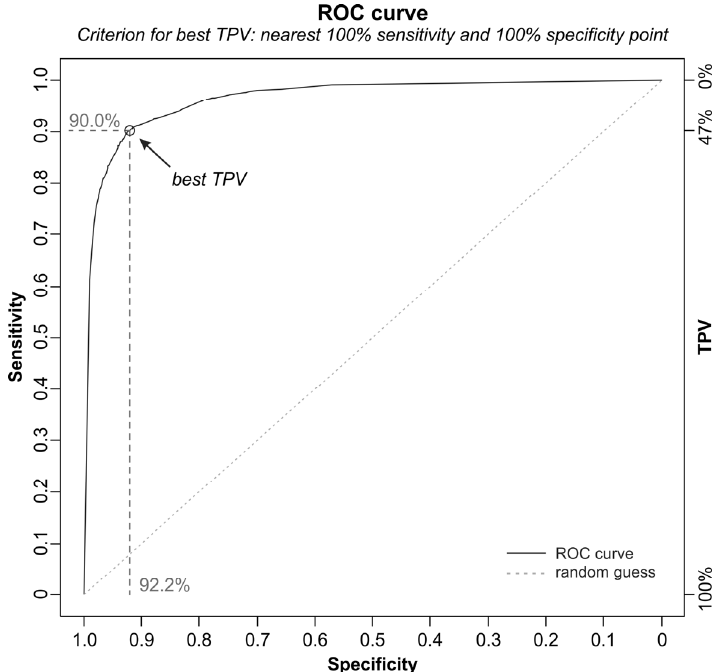
Figure 11. Receiver Operating Characteristic (ROC) curve, depicting sensitivity and specificity indices associated with thematic maps generated from the Probability Image (PI) by varying the Target Probability Value (TPV) from 0% to 100%. The circle points out the best TPV according to the chosen criterion.